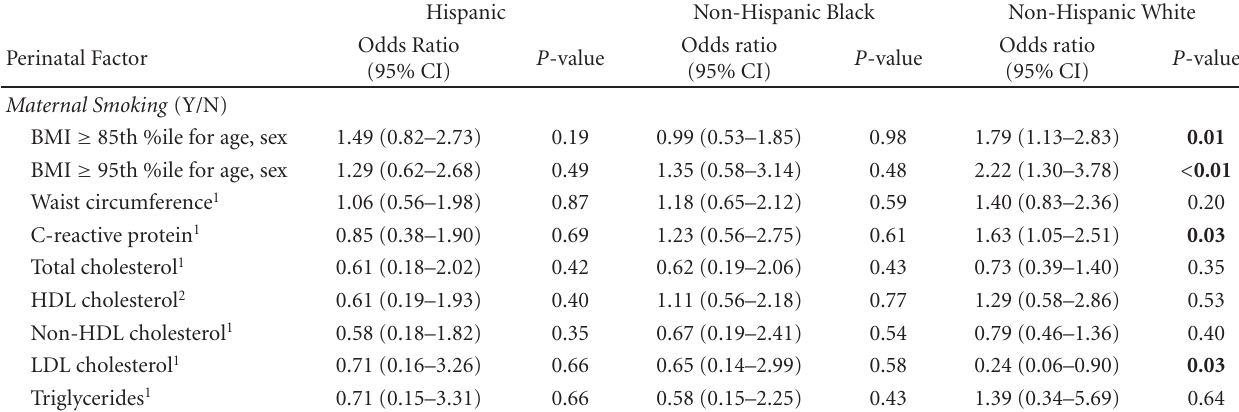
Table 5: Elevated cardiovascular disease risk factors among US 3-to-6-year-olds by ethnic group and maternal smoking during pregnancy, National Health and Nutrition Examination Survey,